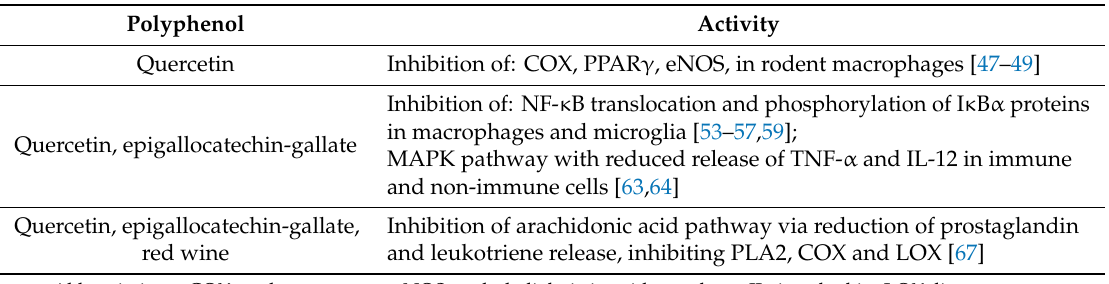
Table 1. Red grape polyphenol-induced antioxidant and anti-inflammatory